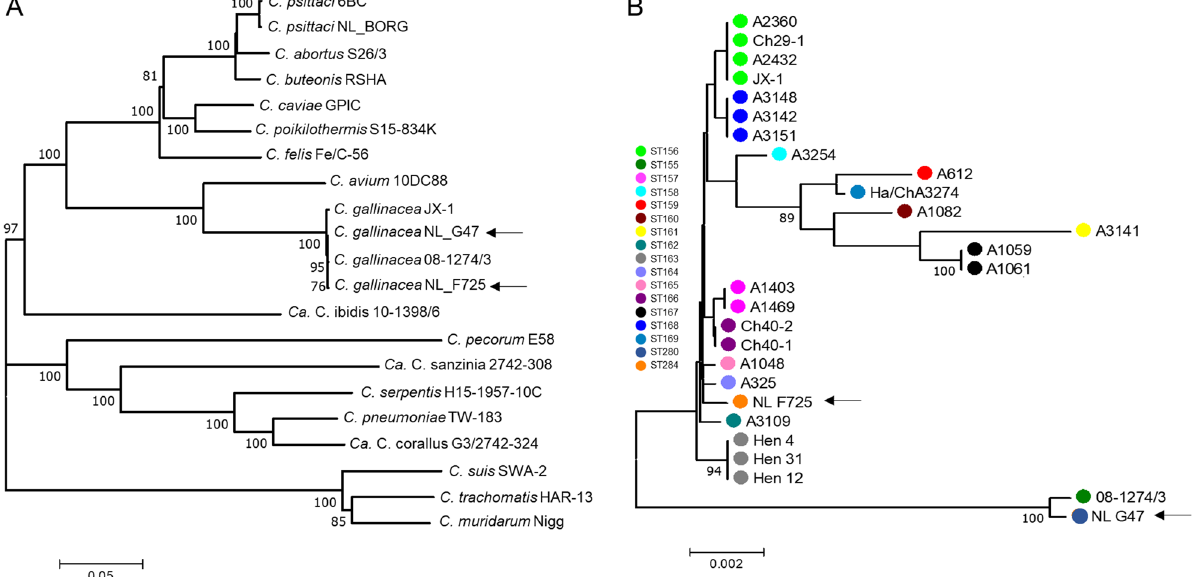
Figure 3. Phylogenetic analyses of concatenated sequences of Chlamydia . Concatenated sequences were aligned and analysed in MEGA7 37 . Numbers on tree nodes indicate bootstrap values over 75% of the main branches. Horizontal lines are scale for nucleotide substitutions per site. ( A ) Neighbor-Joining tree of concatenated sequences of 52 ribosomal genes (rMLST) 14 of Chlamydia Type strains as well as three Candidatus species ( Ca. C. corallus, Ca. C. ibidis and Ca. C. sanzinia), C. psittaci strain NL_Borg and two additional C. gallinacea strains. All C. gallinacea strains (Dutch strains indicated by an arrow) clustered together in a well-supported and distinct clade with Chlamydia avium as the closest relative. ( B ) Neighbor-Joining tree of concatenated sequences of 7 housekeeping genes fragments (MLST) 41 of 27 C. gallinacea strains. Shared Sequence types (ST) in clades are indicated by color and STs are denoted by the color